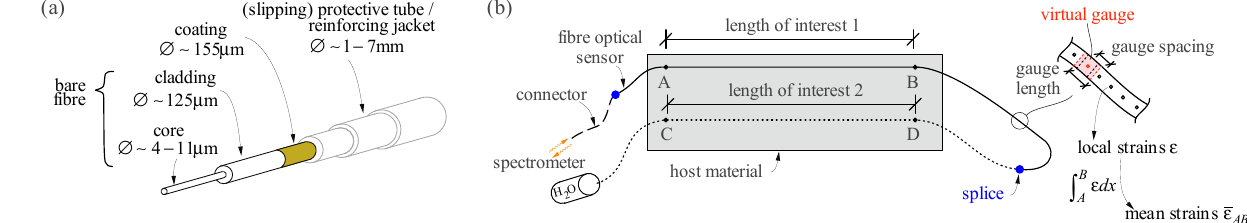
Figure 1. Fibre optical sensors: ( a ) composition of a single-mode fibre; ( b ) terminology used in the present paper.